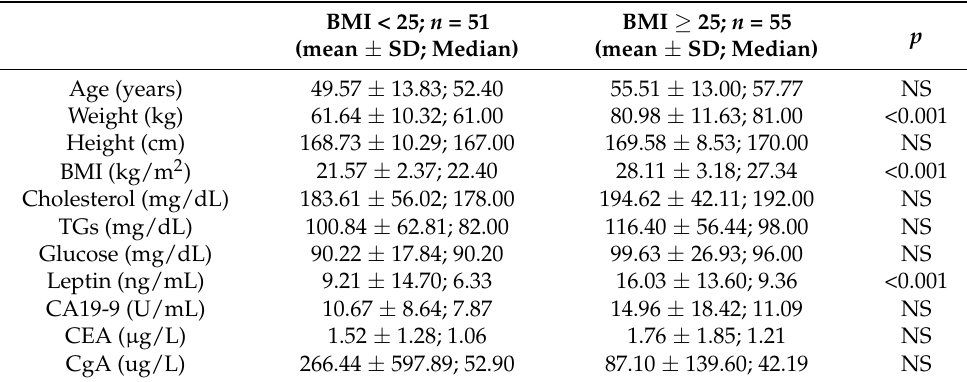
Abbreviations: BMI, body mass index; SD. standard deviation; TGs, triglycerides; CA19-9, carbohydrate antigen 19-9; CEA, carcinoembryonic antigen; CgA, chromogranin A; NS, not